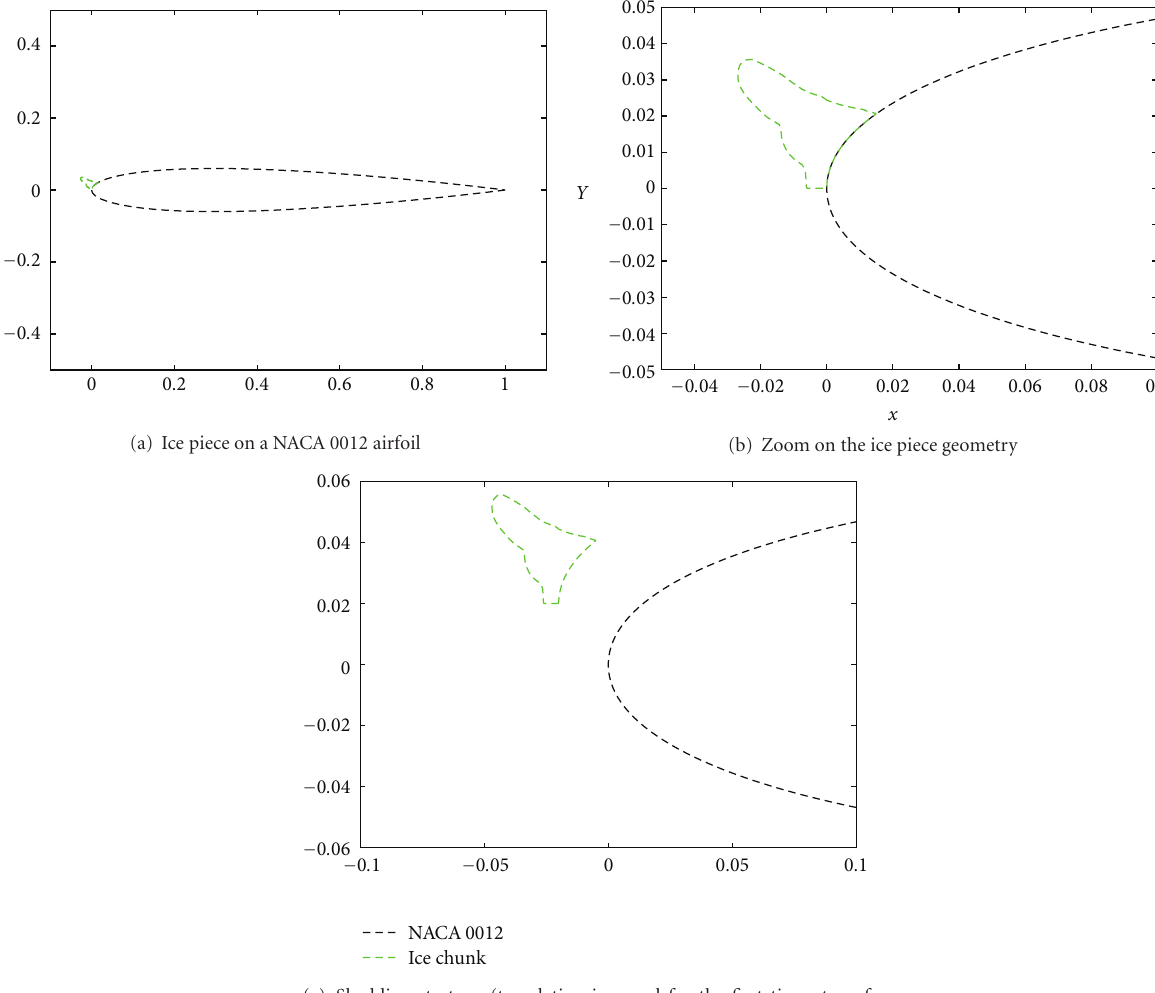
Figure 10: Iced NACA